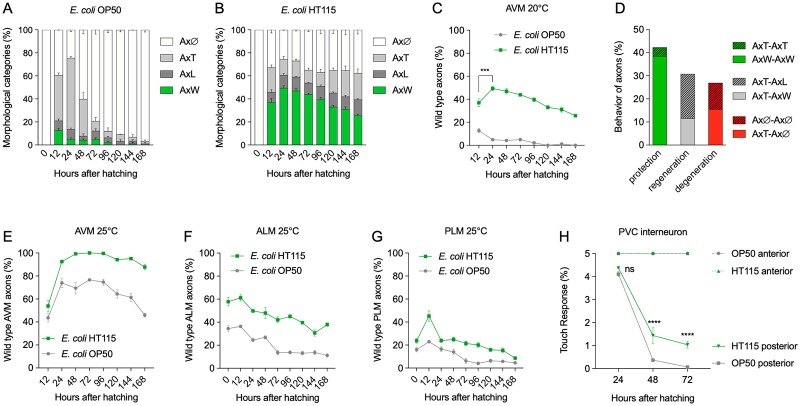
Neuroprotection induced by dietary E. coli HT115 is long lasting and extends to other neuronal types.Time course of axonal categories of worms fed with E. coli OP50 (A) or HT115 (B) for 168 hours. (C) Percentage of wild-type axons in (A) and (B). (D) Proportion of axonal categories in longitudinal assays. Protection (green) indicates axons that were not degenerated over time regardless of the initial category, with the exception of Axϕ. Regeneration (gray) accounts for axons that grew in size over time. Degeneration (red) accounts for axons that degenerated over time. Determination of wild-type axons in AVM (E), ALM (F), PLM (G), and PVC (H) neurons of worms fed E. coli OP50 or HT115. ****P < 0.0001, ***P < 0.001, ns. The underlying numerical data and statistical analysis for each figure panel can be found in S1 and S2 Datasets, respectively. ALM, anterior lateral microtubule; AVM, anterior ventral microtubule; Axϕ, degenerated axon; AxT, truncated axon; AxW, wild-type axon; ns, not significant; PLM, posterior lateral microtubule; PVC, ventral cord interneuron; PVM, posterior ventral microtubule.